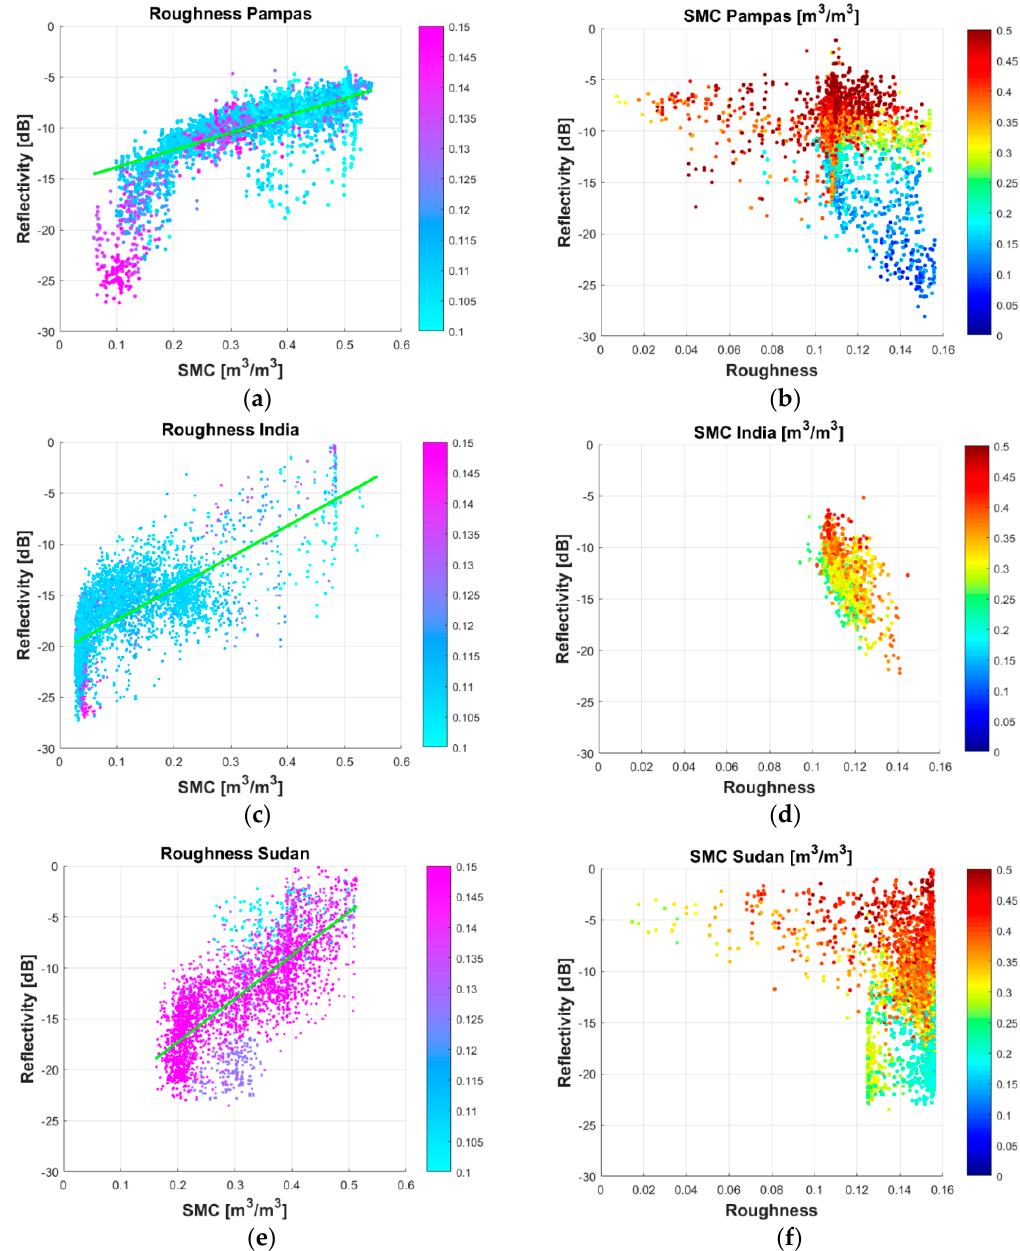
Figure 6. Scatter plots over specific target areas [( a , b ) Argentinian Pampas, ( c , d ) India, and ( e , f ) Sudan] of ( a , c , e ) the CyGNSS reflectivity Γ LHCP,CyGNSS vs soil moisture content (SMC) as a function of surface roughness parameter h and ( b , d , f ) the CyGNSS reflectivity Γ LHCP,CyGNSS vs. surface roughness parameter h as a function of SMC. The selected elevation angles θ e ranges corresponded to the maximum Pearson correlation coefficient between Γ LHCP,CyGNSS and SMC (Table 2). The robust fit regression lines are shown in green.